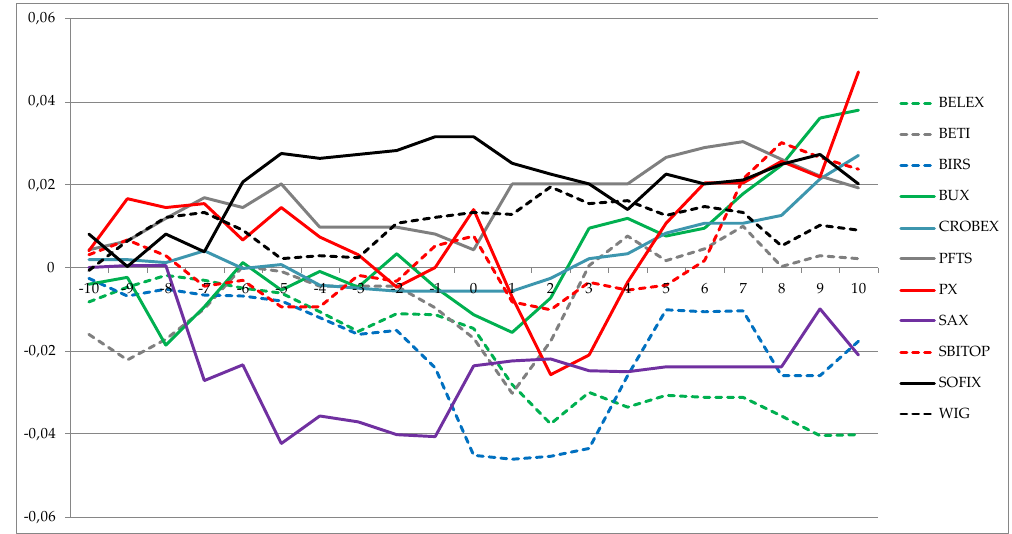
Figure A1. Individual CAR s, CEE regional market factor.